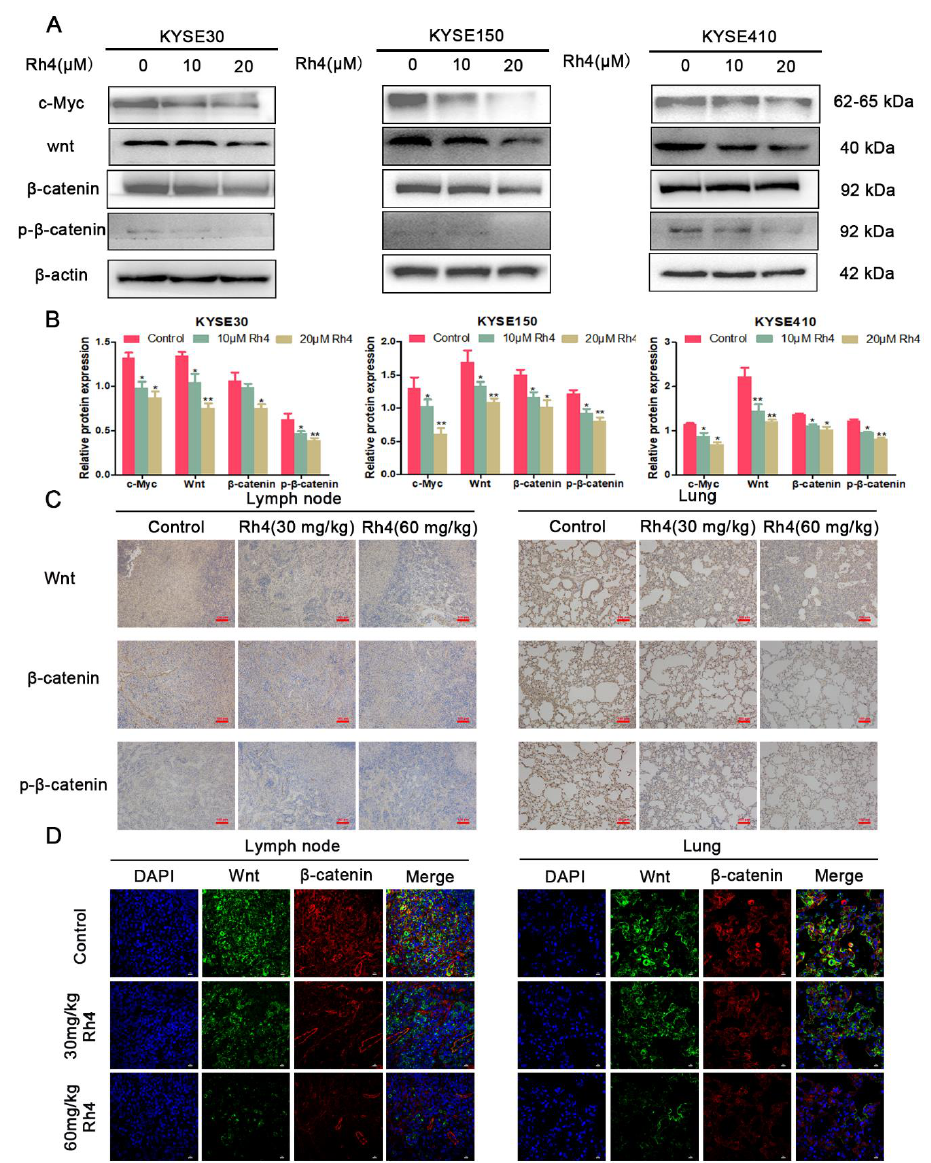
Figure 6. ( A , B ) Relative protein levels of Wnt, β -catenin, and p- β -catenin after KYSE30, KYSE150, and KYSE410 were treated by Rh4. ( C ) Immunohistochemical analysis showed that Rh4 attenuated Wnt, β -catenin, and p- β -catenin in lymph nodes and lungs. Scale bar = 100 µ m. ( D ) Immunofluorescence analysis showed that Rh4 also attenuated the level of Wnt and β -catenin in lymph nodes and lungs. Scale bar = 10 µ m. All data are presented as mean ± SD, * p < 0.05, and ** p <